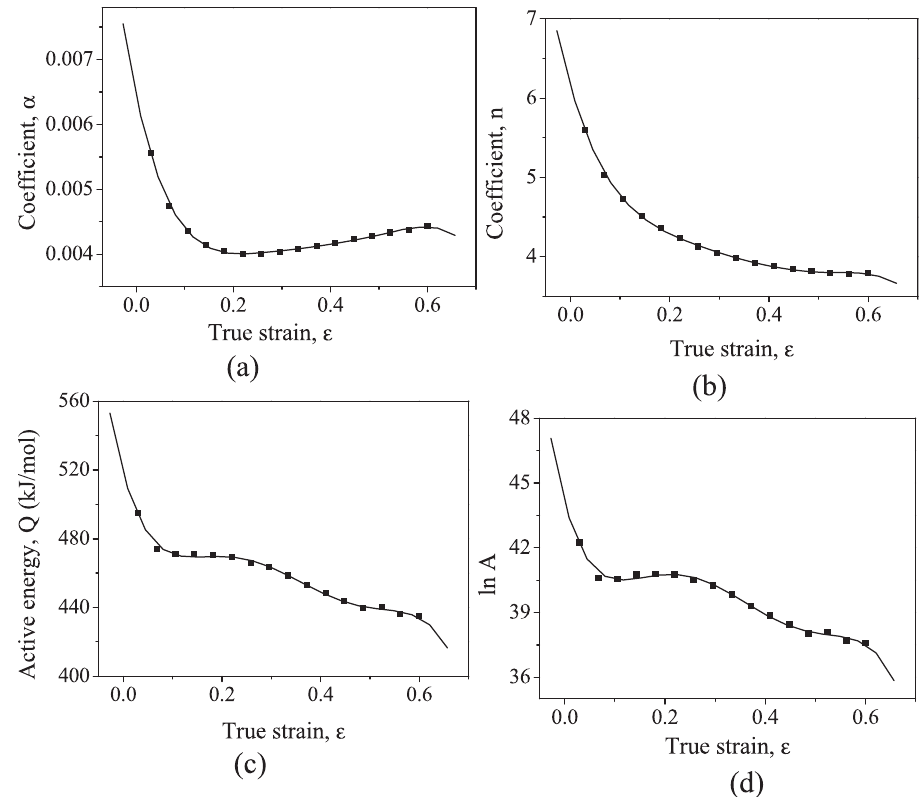
Figure 5: Relationships between (a) a ; (b) n ; (c) Q ; (d) ln A and true strain by polynomial fit of Inconel